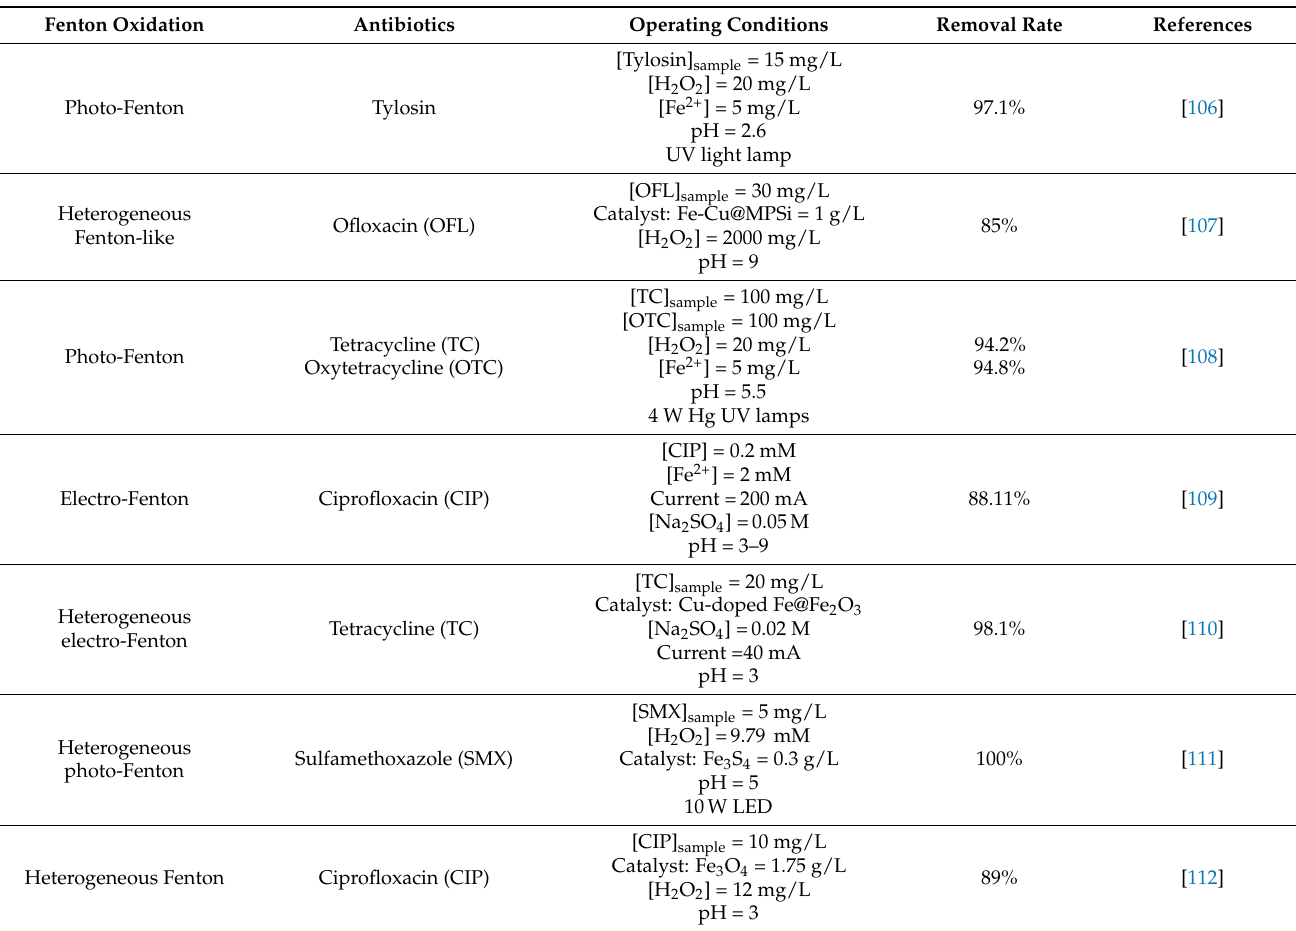
Table 3. The performance of antibiotics removal by using different Fenton-like